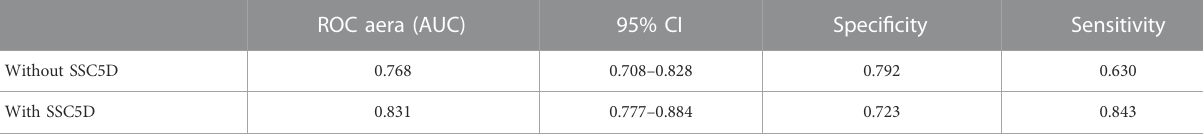
TABLE 4 ROC curve analysis for SSC5D to predict the diagnosis of